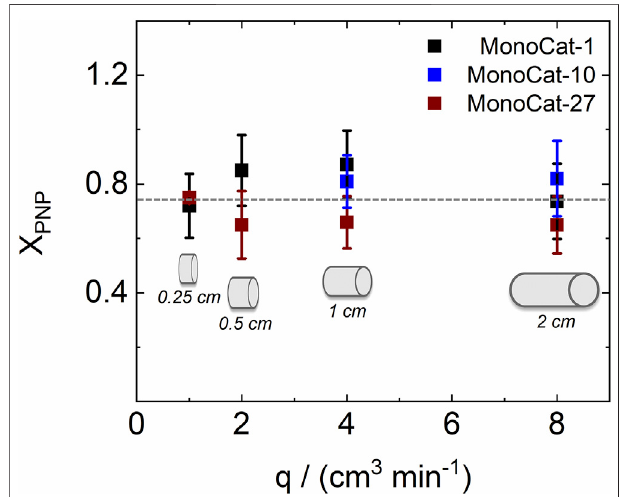
FIGURE 8 | Conversion (X PNP ) at constant contact time ( t c ∼ 2.6 s) as a function of volumetric fl ow rate ( q ) with fi xed diameter ( D (cid:2) 0.5 cm) and variable lengths ( L (cid:2) 0.25, 0.5, 1.0, and 2.0 cm); T (cid:2) 298 K, c PNP (cid:2) 0.40 m M , c NaBH4 (cid:2) 1.60 m M